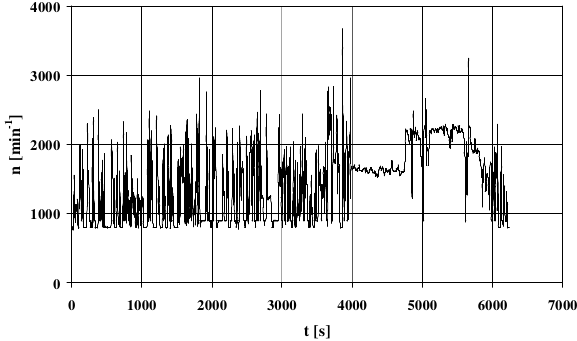
Fig. 3. Engine speed characteristic in the RDE test